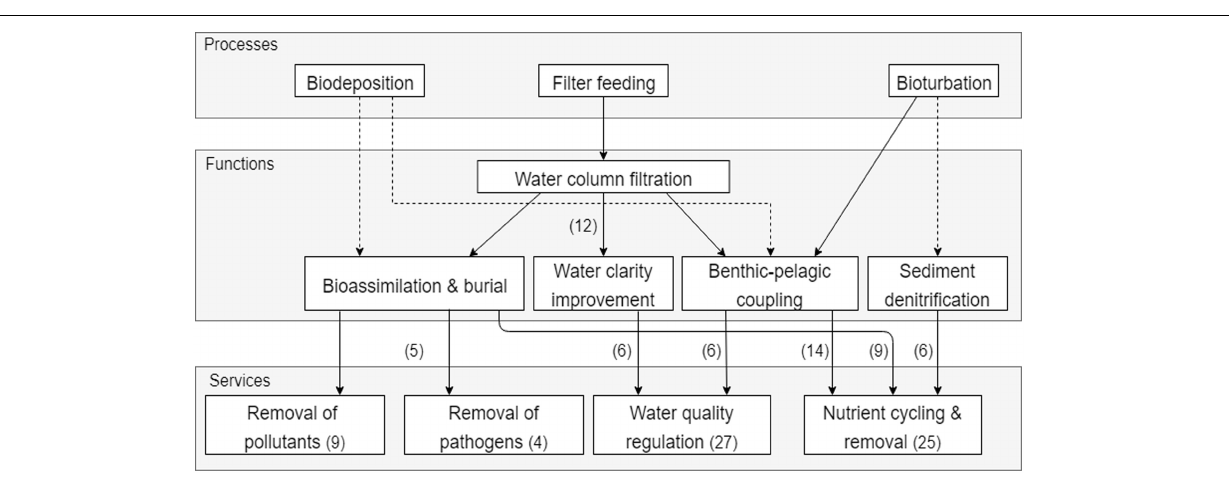
FIGURE 4 | Simplified cascade showing the links between processes, functions, and services in the Coastal health and quality bundle. The number of papers discussing a service is indicated in brackets within the service box, while the number of times links between processes and functions were discussed is indicated in brackets next to the arrows. Dashed lines indicate links that are inferred from expert